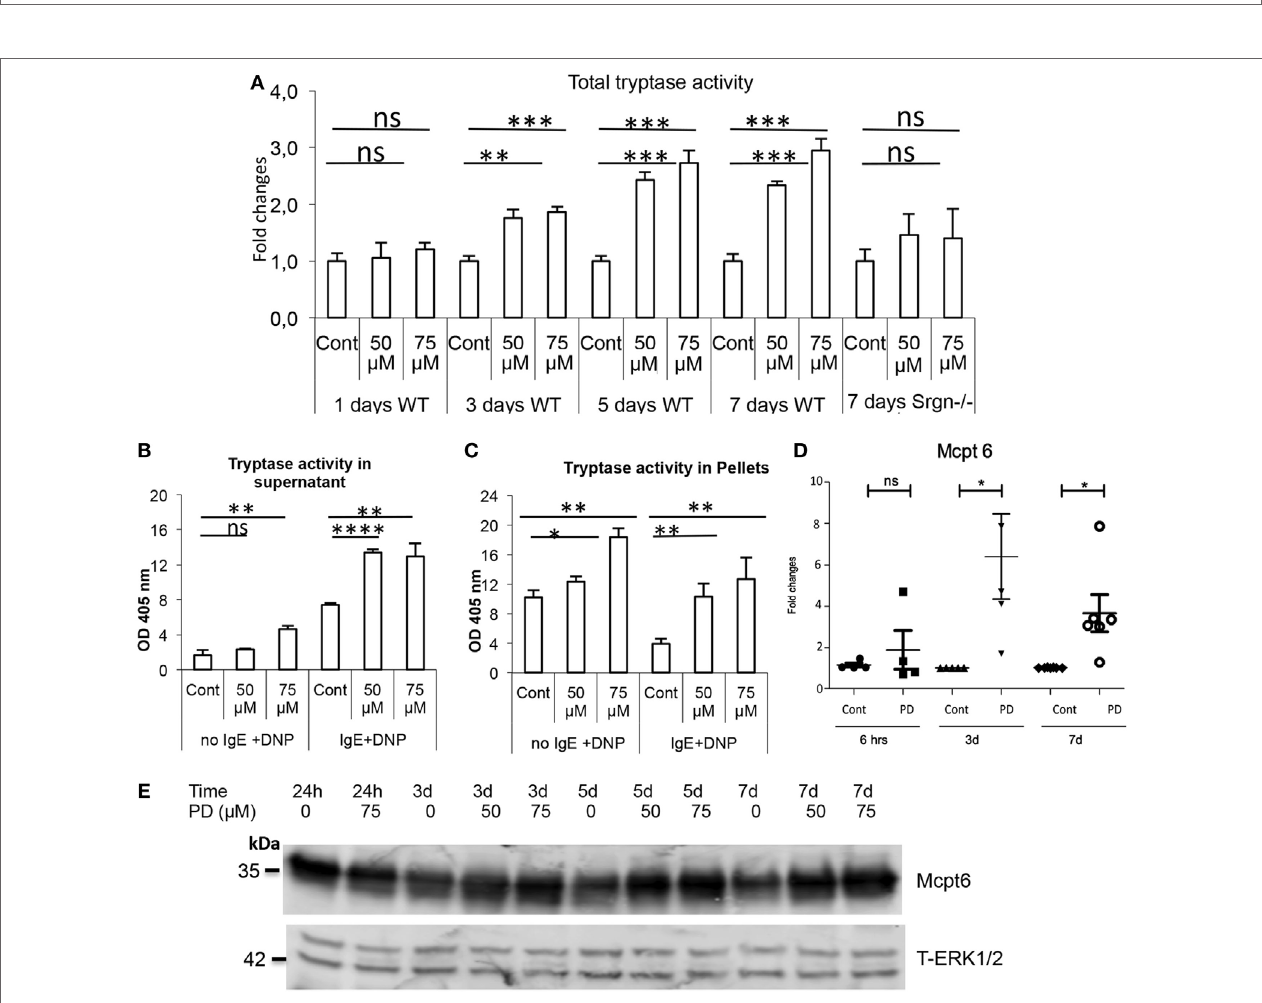
FigUre 6 | MEK1/2 inhibition in mast cells (MCs) causes increased tryptase activity and expression. Bone marrow-derived wild-type (WT) or serglycin − / − (Srgn − / − ) MCs (0.5–1.0 × 10 6 cells/ml) were incubated with PD98059 (PD) at the concentrations and time periods indicated. (a) Total tryptase enzymatic activity in the cells was quantified by using a chromogenic substrate (S-2288). Note the robust increase in tryptase activity after long-term treatment with PD98059. (B,c) MCs were sensitized overnight as indicated by incubation with anti-DNP IgE, followed by IgE receptor crosslinking by addition of DNP-HSA. Next, tryptase activity in the supernatants (B) or in the residual cell pellets (c) was quantified. (D) MCs (0.5–1.0 × 10 6 cells/ml) were incubated with PD98059 (50 µM) for the time periods indicated, followed by isolation of total RNA and quantification of mRNA encoding tryptase (Mcpt6) by qPCR ( n ≥ 3). (e) Western blot analysis revealing increased levels of tryptase (Mcpt6) protein in MCs subjected to long-term treatment with PD98059 (50 µM). Total ERK1/2 was used as loading control ( n = 6).